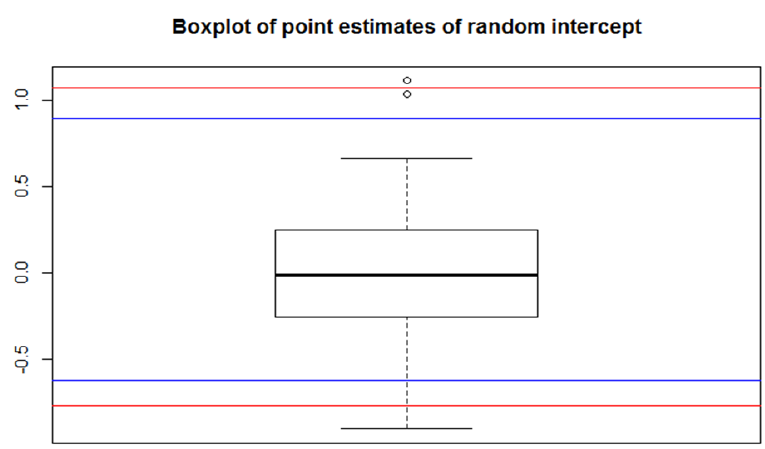
Figure 4. Boxplot of the point estimates of the random intercept of the multilevel model. The horizontal blue lines correspond to the quantiles of 2.5% and 97.5%. The horizontal red lines correspond to the quantiles of 1% and 99%.